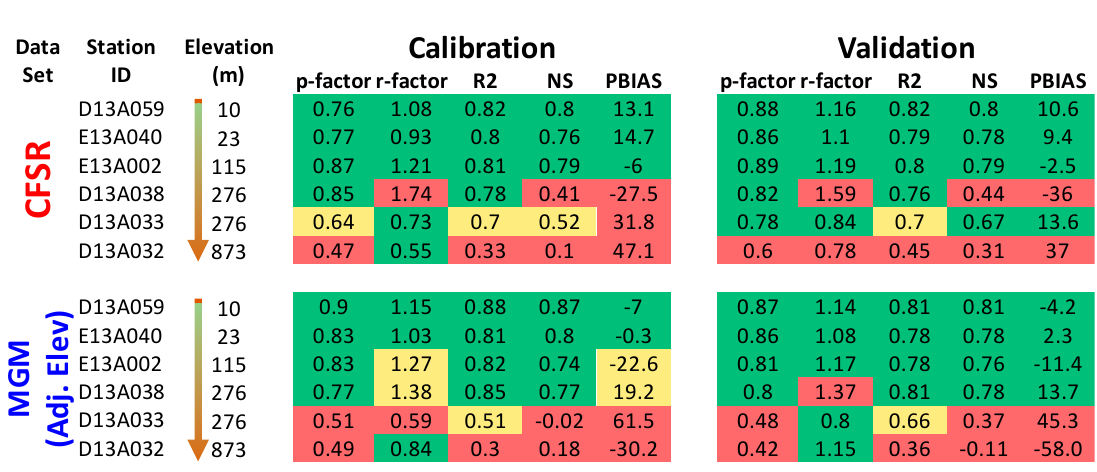
Figure 11. Heat map for the model performance criteria for calibration and validation.